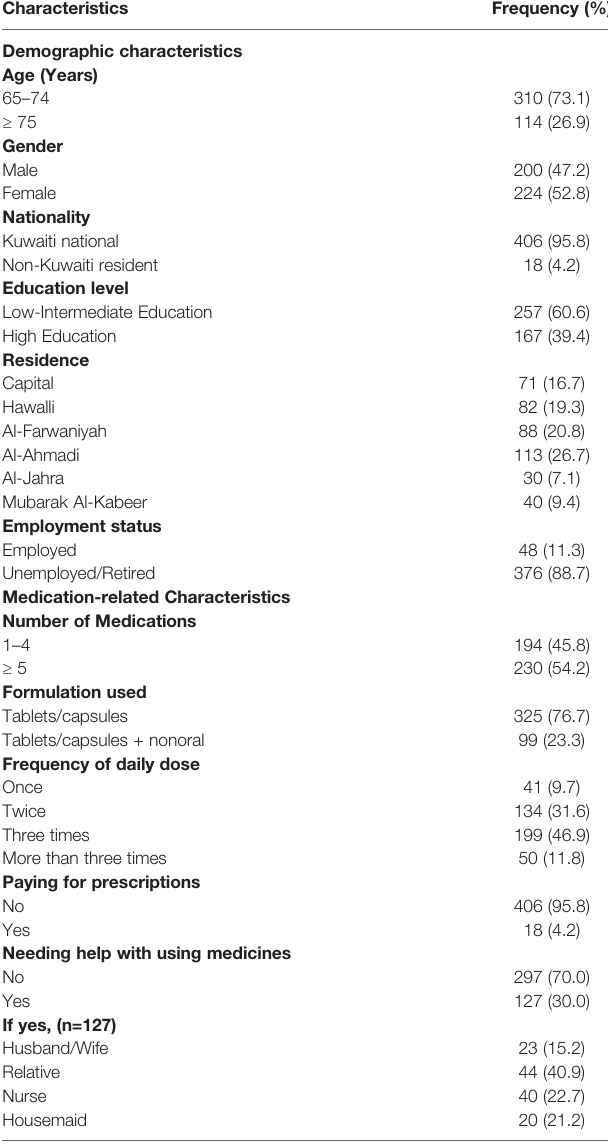
TABLE 1 | Demographic and medication-related characteristics of the respondents (n =